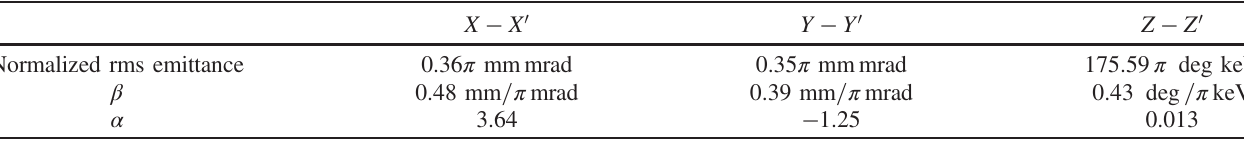
TABLE II. Beam parameters of the used input beam for the DTL rms envelope matching NSGAII simulation.